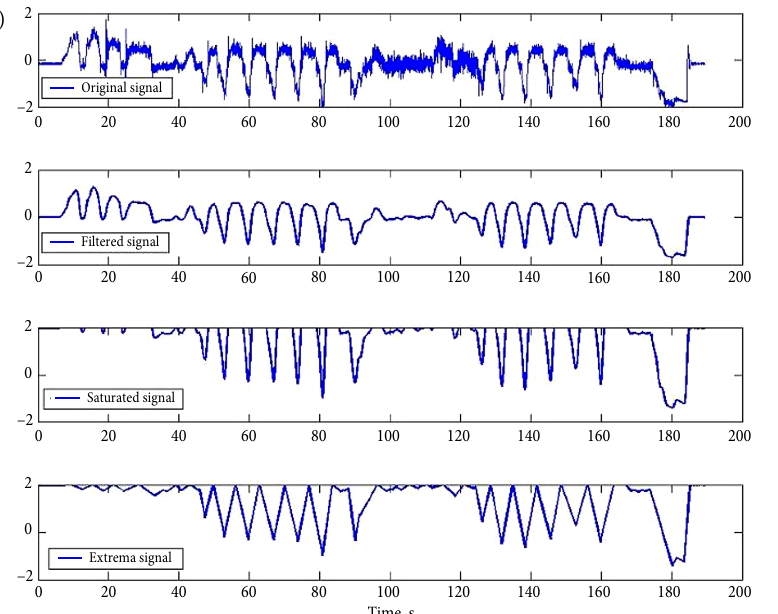
Fig. 5. Acceleration signal: a – processing; b –